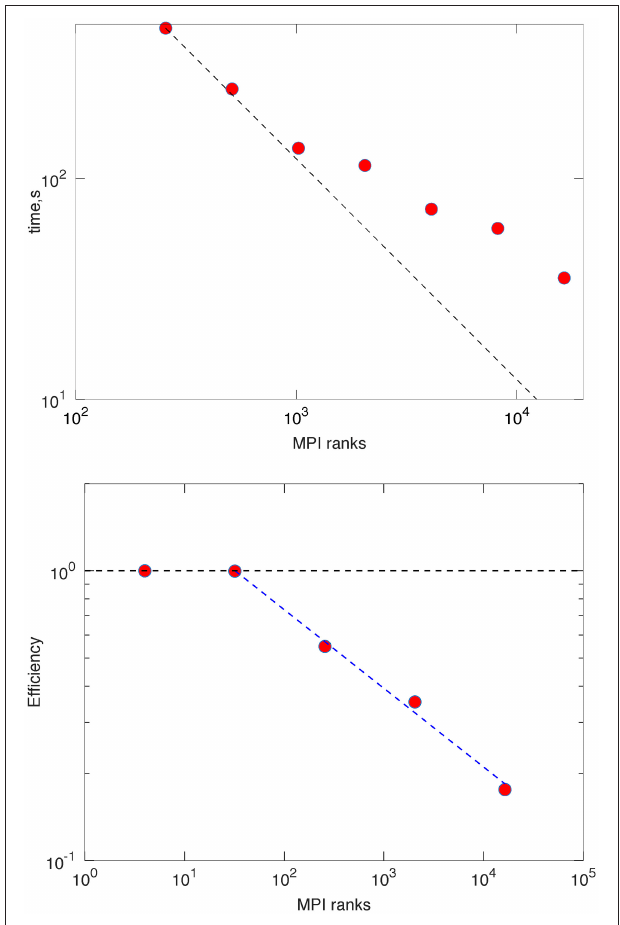
FIGURE 1 | Examples of strong (Top) and weak (Bottom) scaling of SPS obtained on Blue Waters supercomputer. Dashed black lines denote ideal scalings. The efficiency of the weak scaling is defined as the ratio between the number of MPI ranks and simulation time normalized to that value for the reference case with 4 MPI ranks.